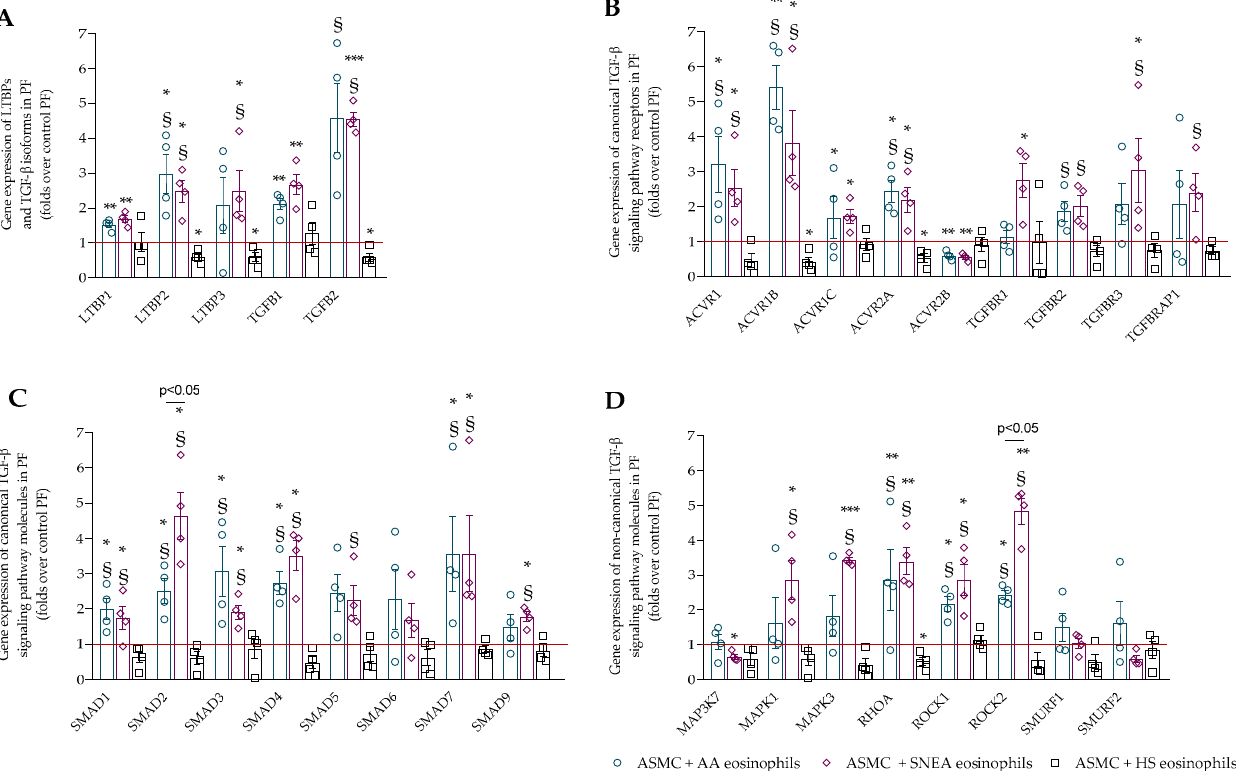
Figure 5. ( A )—Gene expression of LTBPs and TGF- β isoforms in PF; ( B )—Gene expression of canonical TGF- β signaling pathway receptors in PF; ( C )—Gene expression of canonical TGF- β signaling pathway molecules in PF; ( D )—Gene expression of non-canonical TGF- β signaling pathway molecules in PF. AA—allergic asthma; HS—healthy subjects; SNEA—severe non-allergic eosinophilic asthma. AA, n = 4, SNEA, n = 4, HS, n = 4. Data are presented as mean ± SEM, fold change over control PF. * p <0.05 compared with control PF; ** p < 0.01 compared with control PF; *** p < 0.001 compared with control PF; § p < 0.05 compared with HS eosinophil effect. Statistical analysis between investigated groups—two-sided Mann–Whitney U test (independent data); two-sided Wilcoxon matched-pairs signed-rank test (dependent data); and Wilcoxon signed-rank test, which was used for gene expression analysis against control PF that were not incubated with eosinophils.